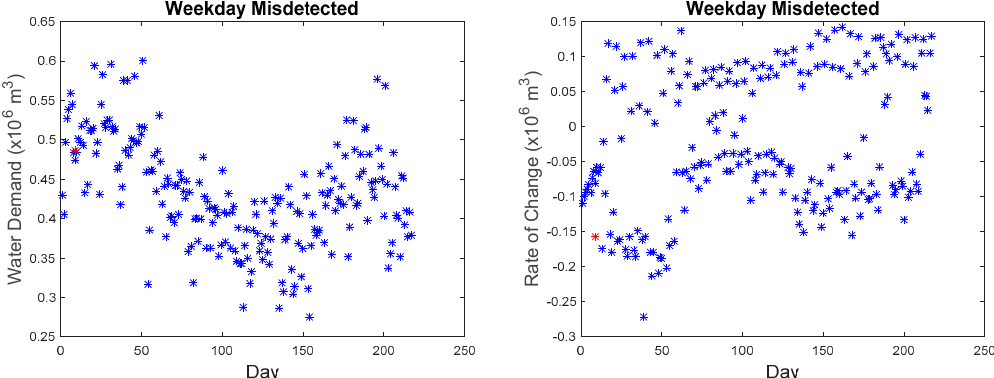
Figure 16. Comparison of first missed detected anomaly with other points.